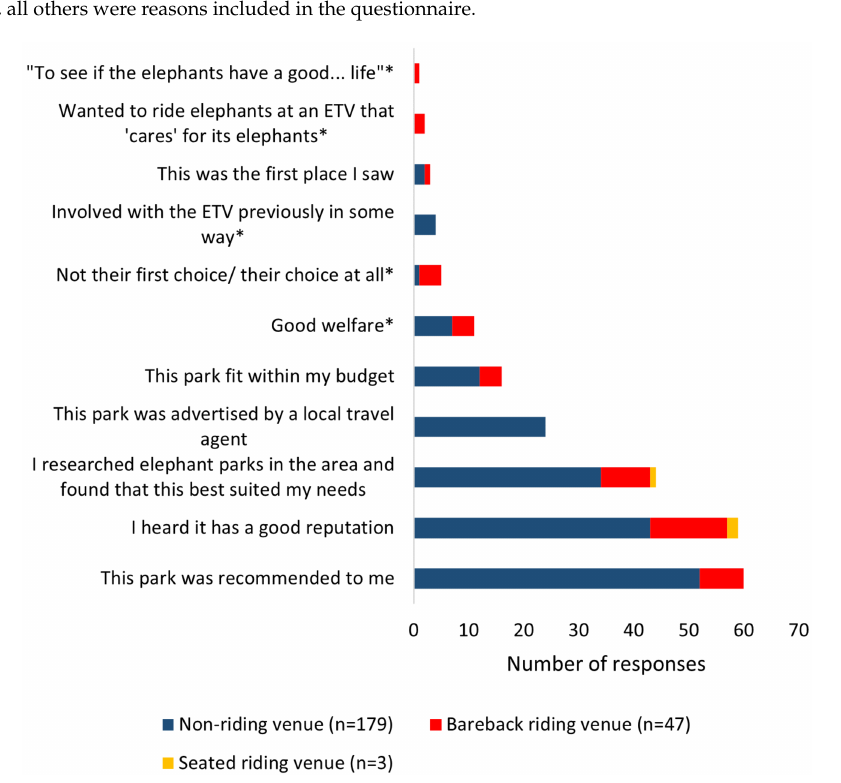
Figure 2. Respondent reasons, per venue type, for choosing the ETV they visited. ’*’ Denotes themes constructed from participants’ responses, all others were reasons included in the